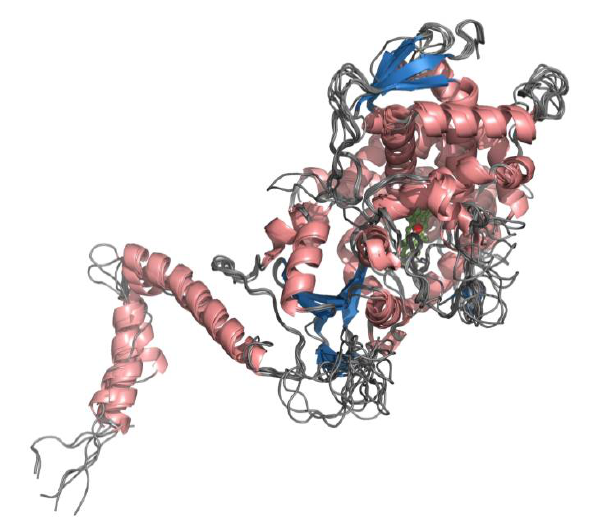
Figure 2. Superimposition of 3D structural models of 11 CYP51s from Tremellomycetes . Helices and beta sheets are shown in salmon and sky blue. Heme is shown in green along with the Fe atom in red.